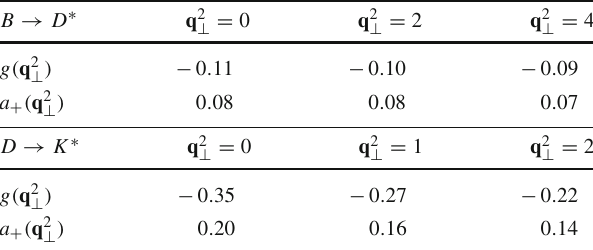
Table 1 Numerical results of the zero-mode independent form factors g ( q 2 ⊥ ) and a + ( q 2 ⊥ ) at q 2 ⊥ = ( 0 , 2 , 4 ) GeV 2 for B → D ∗ transition and at q 2 ⊥ = ( 0 , 1 , 2 ) GeV 2 for D → K ∗ transition